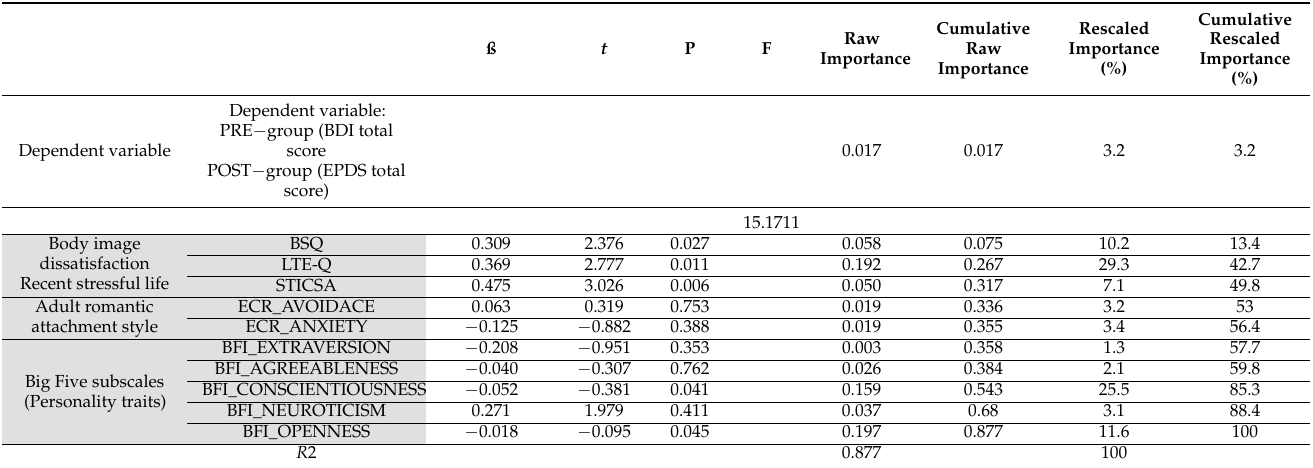
Table 5. Hierarchical Regression (HR) and Relative Weight Analysis of PRE-partum group. ß P F Raw Importance